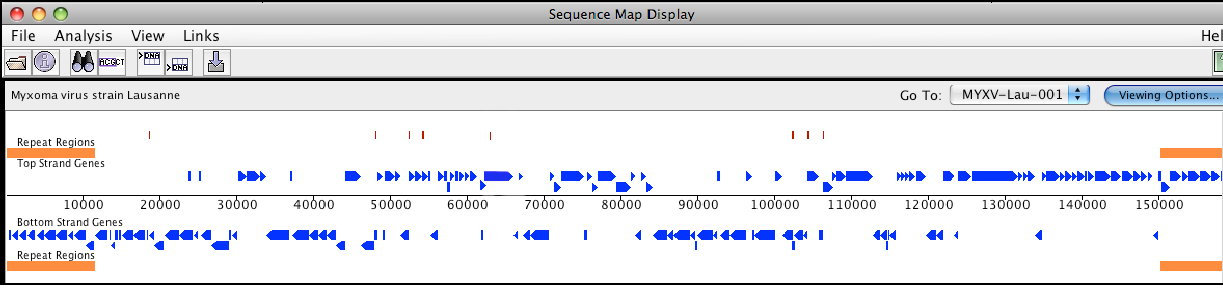
Figure 1. MYXV genome map with JaPaFi hits. Blue arrows are MYXV open reading frame (ORFs) and the red tick marks above are JaPaFi hits. Orange bars at the right and left extremities are the inverted terminal repeat regions of the